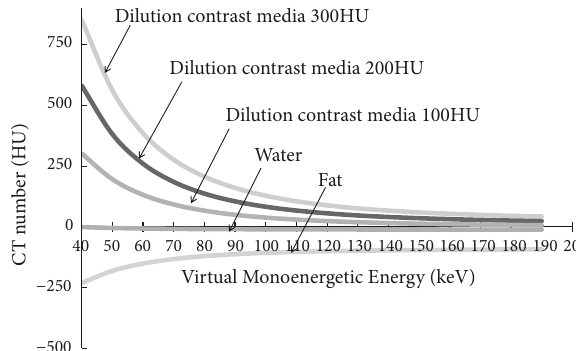
Figure 4: Changes in the energy with regard to VMI and CT